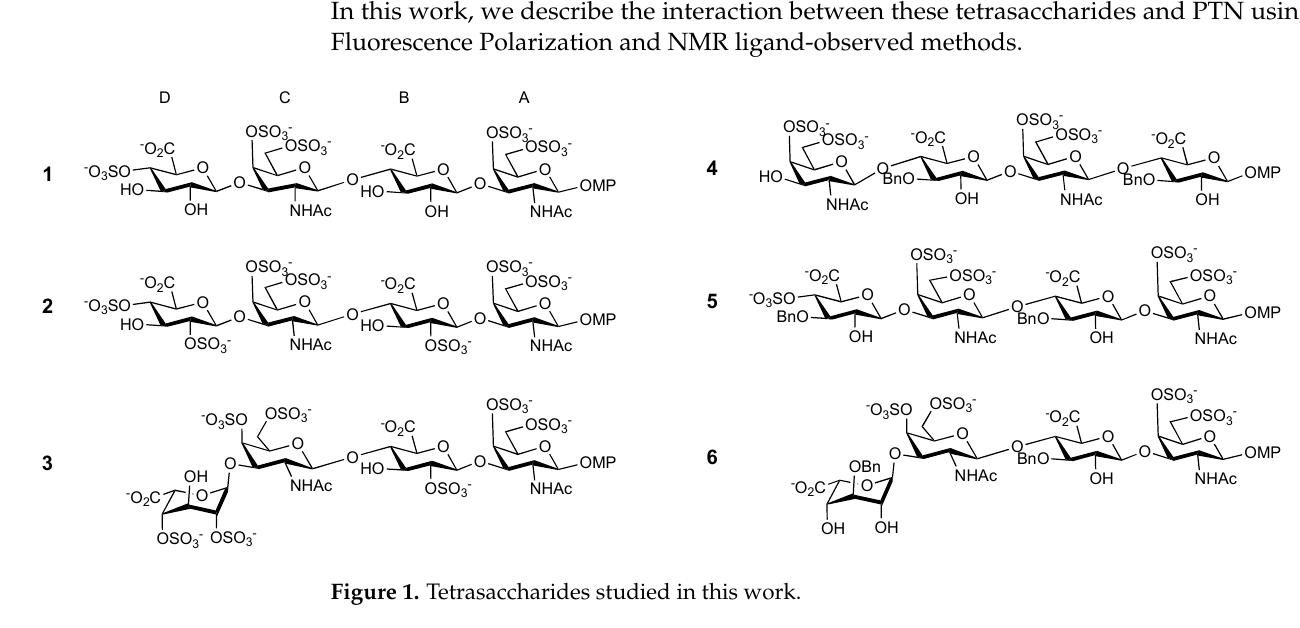
Figure 1. Tetrasaccharides studied in this work.